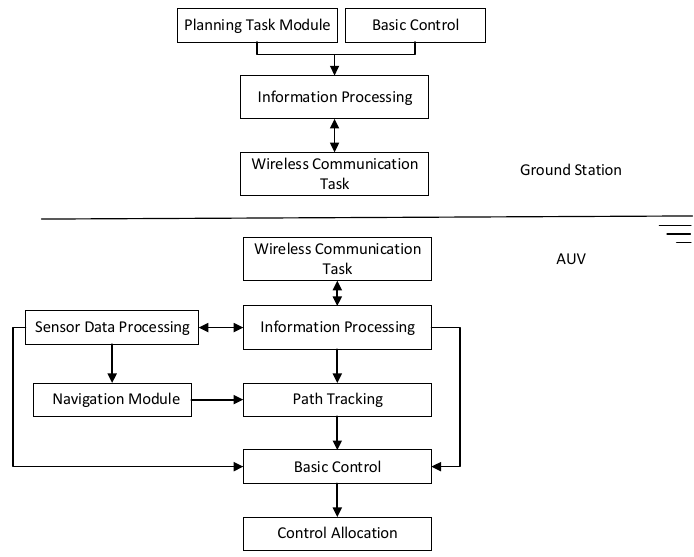
Figure 6. Logic structure diagram of AUV software system.